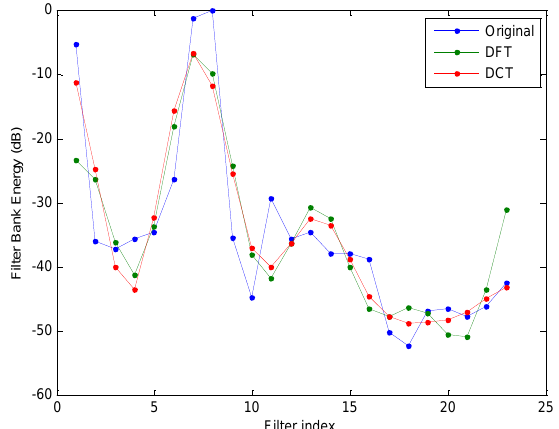
Figure 12. Original FBE of a frame and its approximate value using C = 10 harmonics (cepstral) components of the DFT and the DCT expansion.